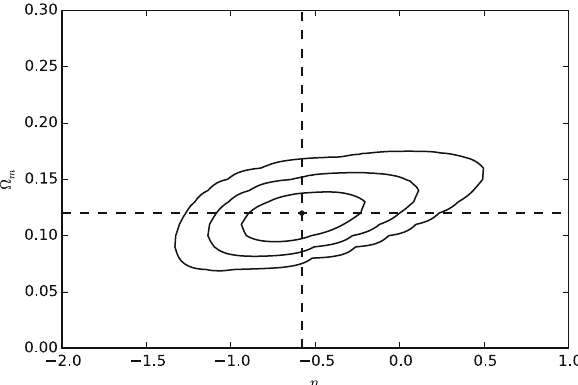
) = ( − 1 . 2 , 66 ) , (Ω D 0 0 ) = ( − 1 . 1 , 0 . 13 m